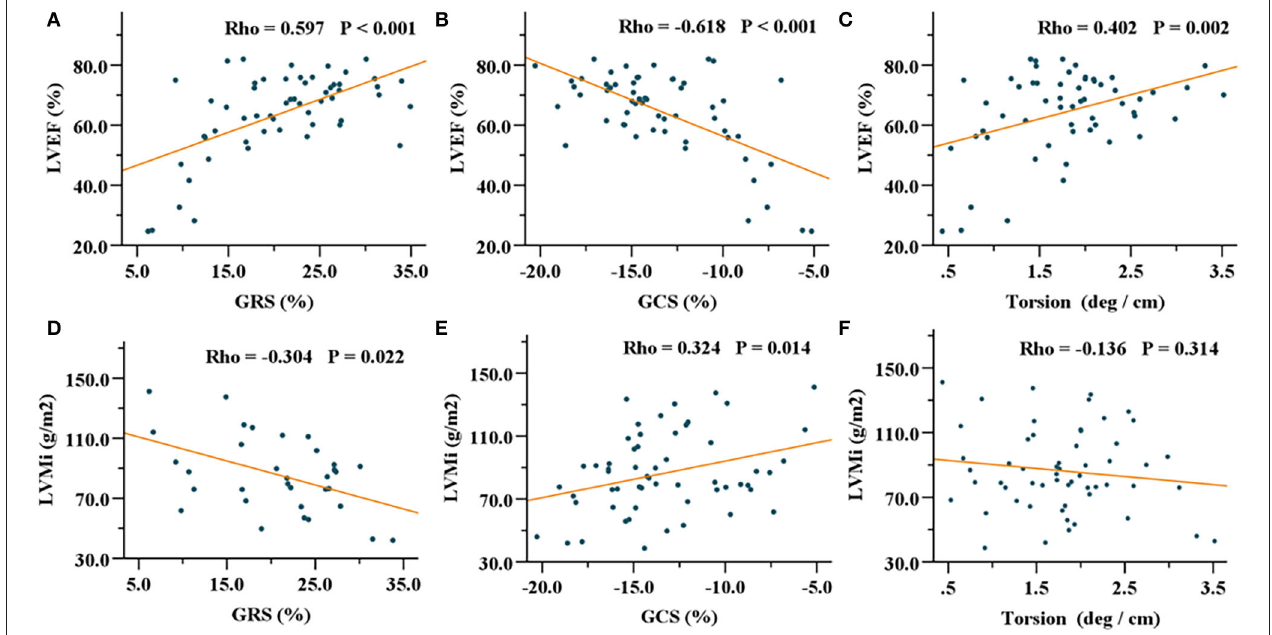
FIGURE 3 | Correlations of GRS, GCS, and torsion with LVEF (A–C) and LVMi (D–F) in the HCM group. GRS, global radial strain; GCS, global circumferential strain; LVEF, left ventricular ejection fraction; LVMi, left ventricular mass index; HCM, hypertrophic cardiomyopathy.